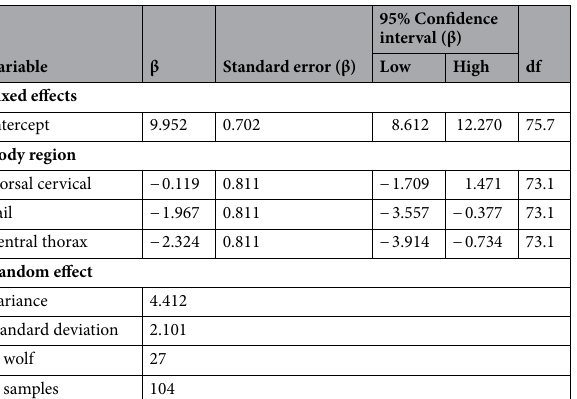
Table 1. Summary of the linear mixed model of hair cortisol concentration by body region. Individual wolf included as random effect, lumbar body region as reference class. Results from 27 wolves with 4 body regions each (4 outliers excluded).